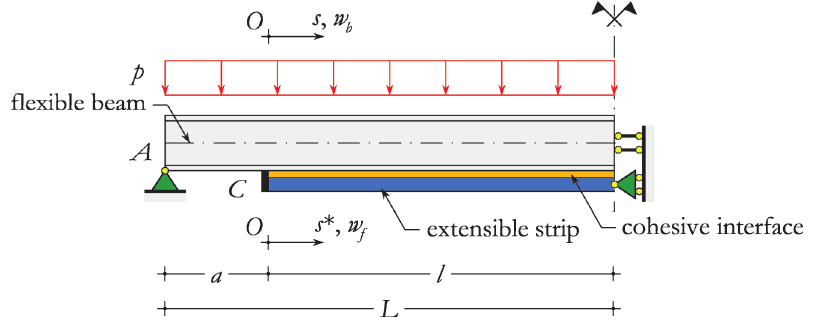
Figure 3: Mechanical model of the strengthened